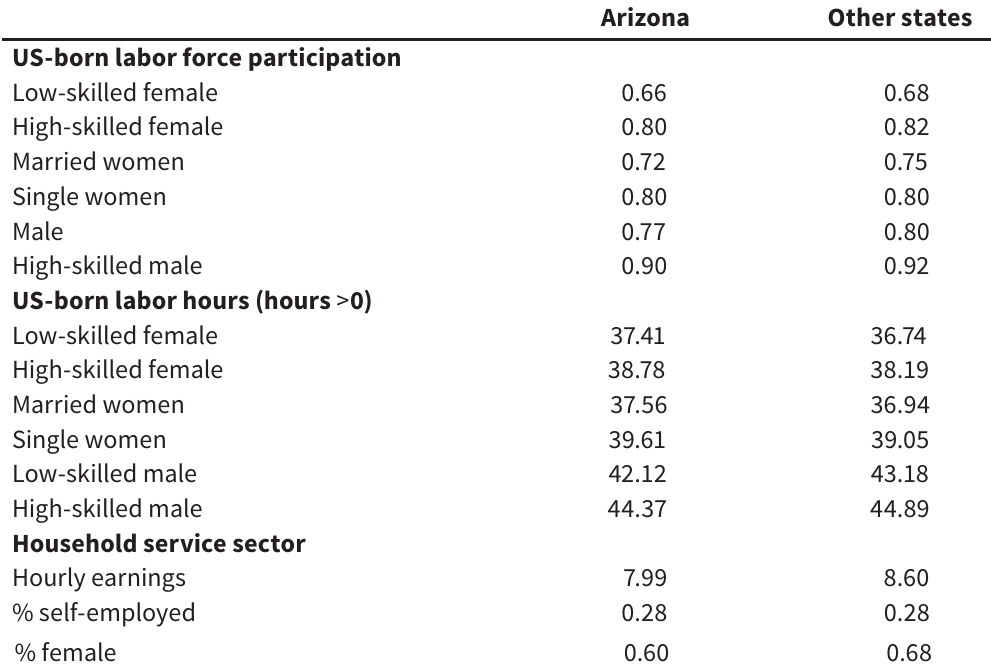
Arizona Other states